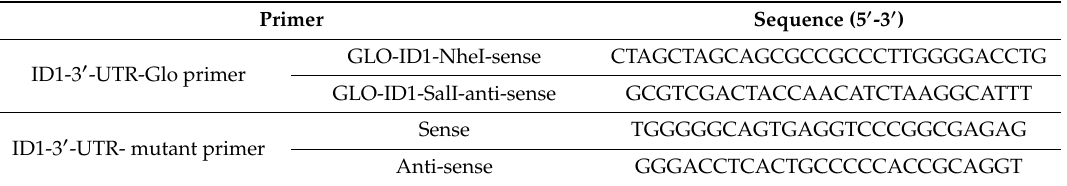
Table 2. Primers for ID1-3‘-UTR plasmids